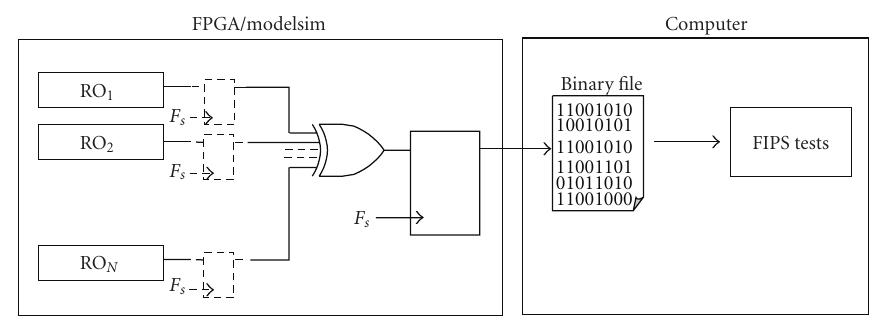
Figure 2: Simulation and experimental